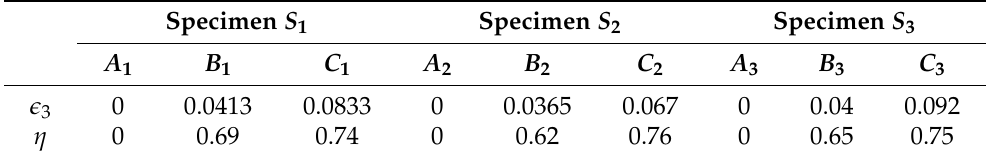
Table 3. Deviatoric stress ratio η and axial strain (cid:101) 3 corresponding to the critical points of specimens S 1 , S 2 , and S 3